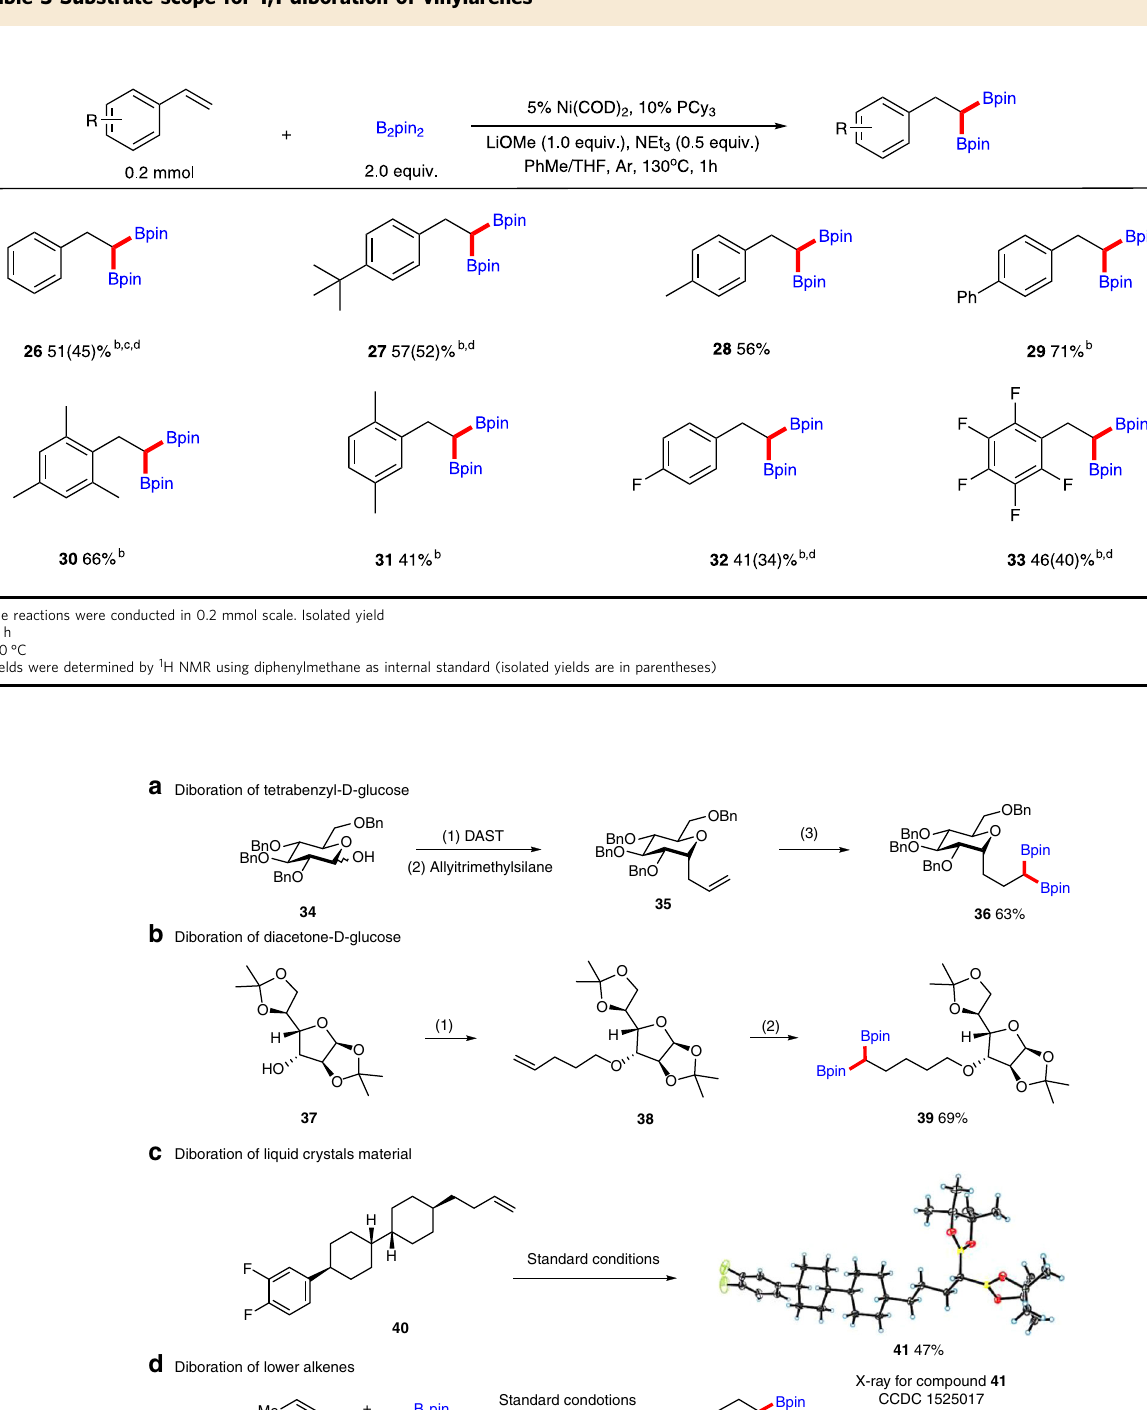
Table 3 Substrate scope for 1,1-diboration of vinylarenes a